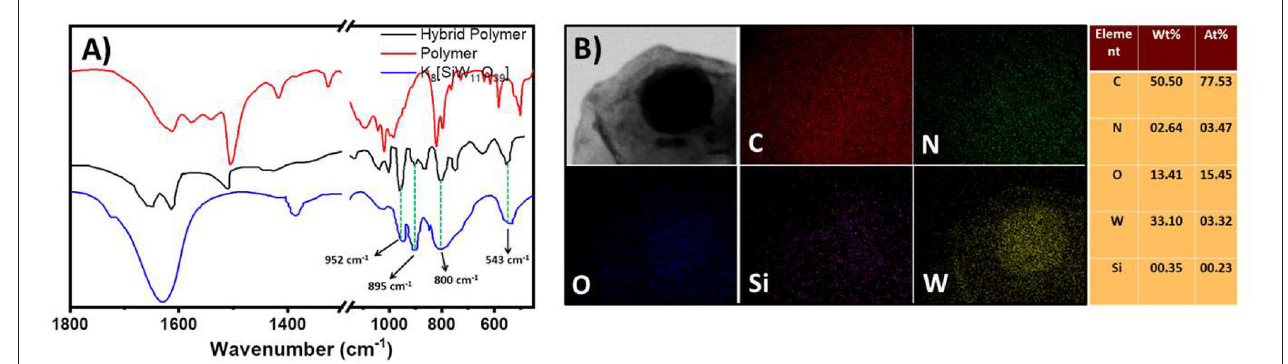
FIGURE 6 | (A) Comparison of IR spectra of the polymer, OM-polymer hybrid, and K 8 [SiW 11 O 39 ]. (B) EDAX mapping and elemental percentage of the (C